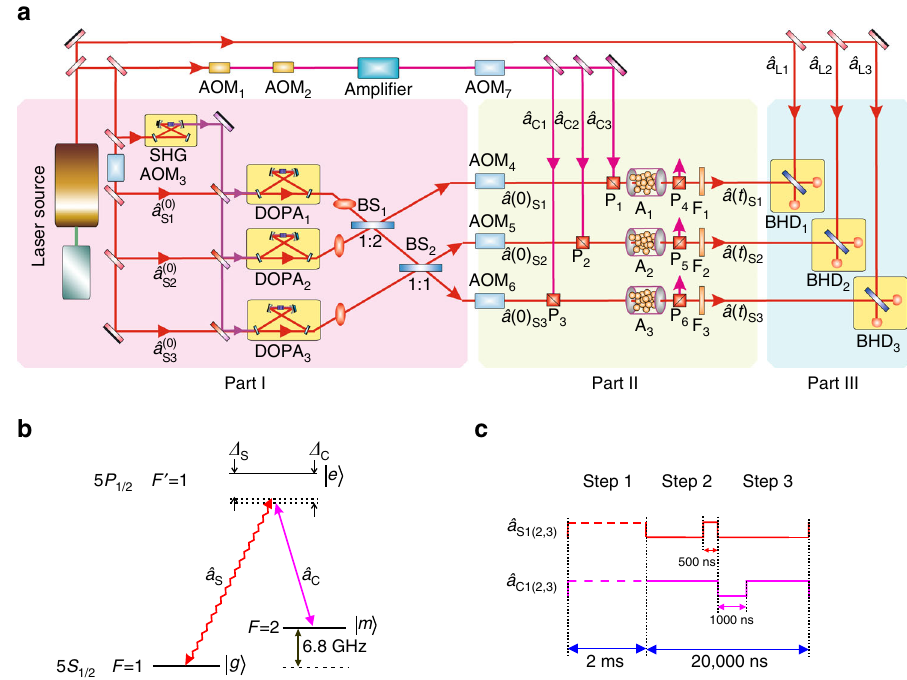
Fig. 1 Schematic diagram. a Experimental set-up. It includes three parts, Part I is the generation system of tripartite optical entanglement; Part II expresses the transportation of entanglement of optical modes to three distant atomic ensembles; Part III is the entanglement veri fi cation system. A 1 – 3 , atomic ensemble 1 – 3 ; DOPA 1 – 3 , degenerate optical parametric ampli fi er 1 – 3 ; SHG, second harmonic generator; AOM 1 – 7 , acousto-optical modulator 1 – 7 ; BS 1 – 2 , beam